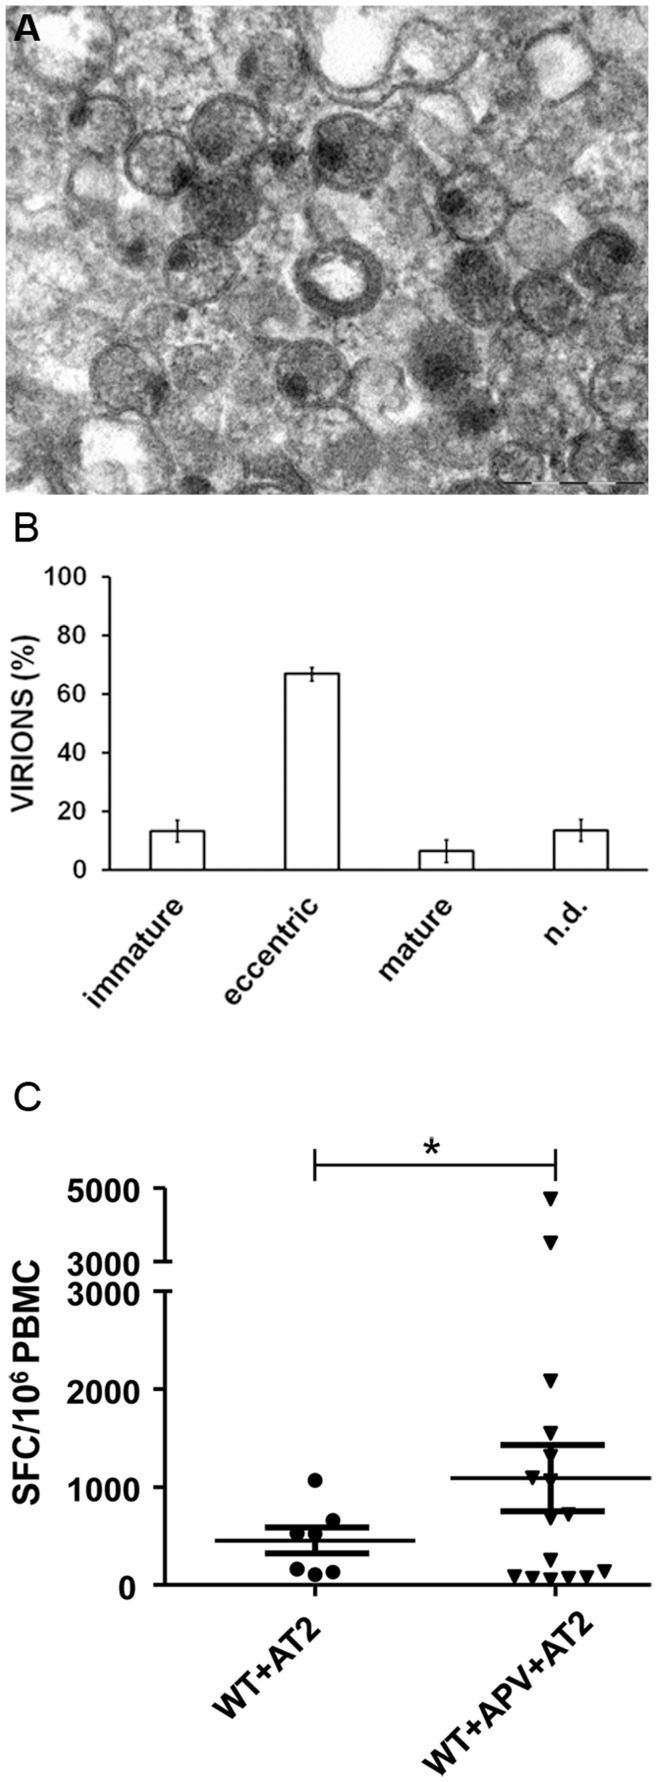
Immature NL4-3 virions improved the elicited cellular immune response.(A) Electron microscopy analysis of purified NL4-3 virions treated with AT-2 and APV. Different virion morphologies were observed; most were immature and eccentric. (B) 52 electron-micrographs were analysed for virus morphologies. The APV incubation reduces mature virions but increases immature and eccentric forms. Error bars represent standard deviaations. (C) Twenty-one cryopreserved PBMCs from HIV seropositive individuals were assessed by ELISPOT to detect IFN-γ production. PBMCs were pulsed with 200 ng/ml p24 equivalents in all cases. Magnitude response was significantly lower against WT inactivated virions (WT+AT-2) than against WT+APV+AT-2 (*p<0.05). Averaged values from duplicate wells normalized to SFC/106 PBMCs are shown for the stimulation conditions indicated. Plots represent mean ± standard error of the mean (SEM). Positivity threshold for each construct or antigen was defined as at least 50 SFC/106 PBMC and at least twice that of the control medium.